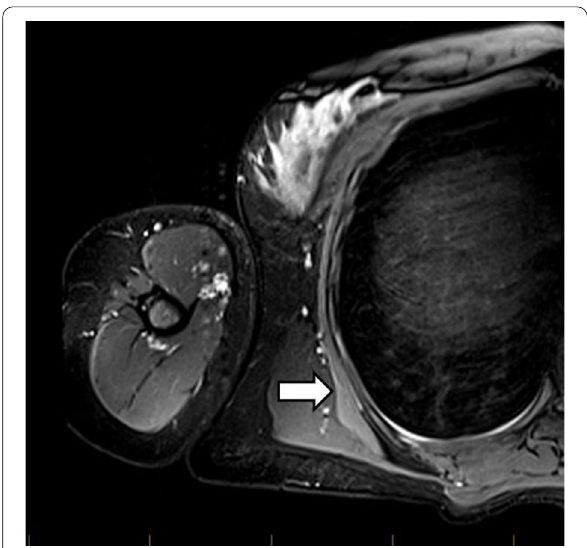
Fig. 1 Axial proton density fat saturation (PDFS) image of a 30-year-old female who presented with medial scapular winging. There is denervation oedema of the serratus anterior (arrow) which is in the distribution of the long thoracic nerve (not